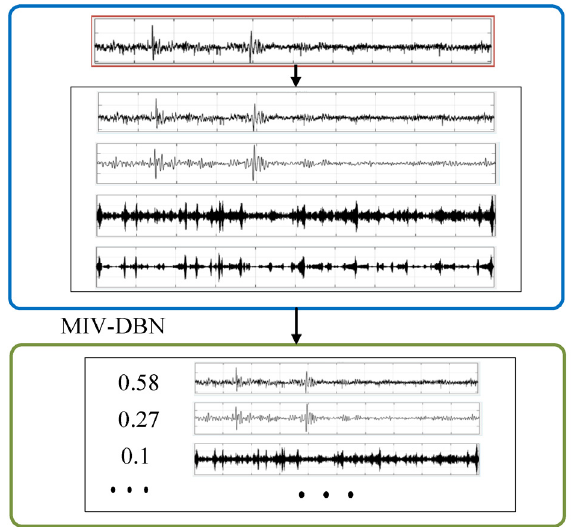
Figure 5. Result of mode sort under the inner raceway fault vibration signal.